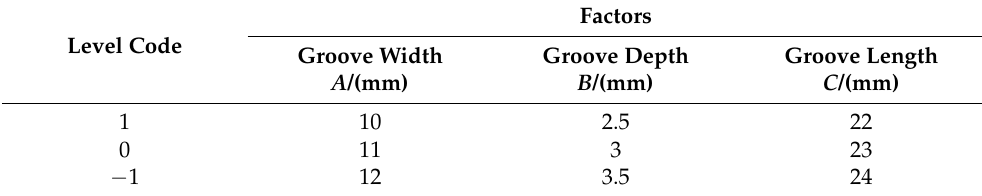
Table 2. Coding of test factors.